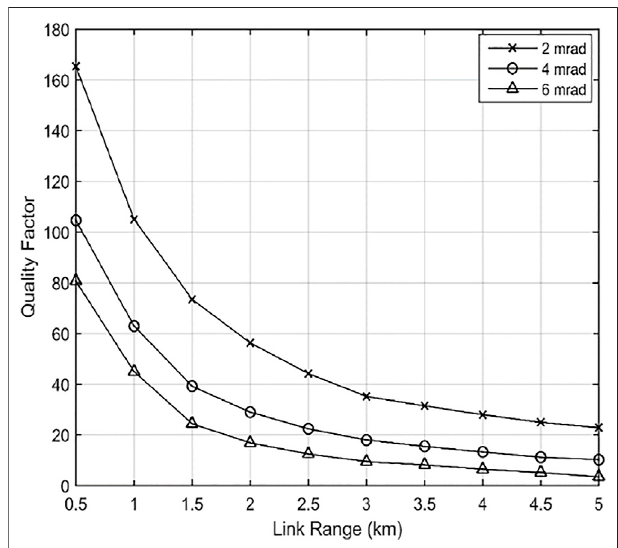
FIGURE 4 | Received Power vs. Link Range for different beam divergence scenarios.